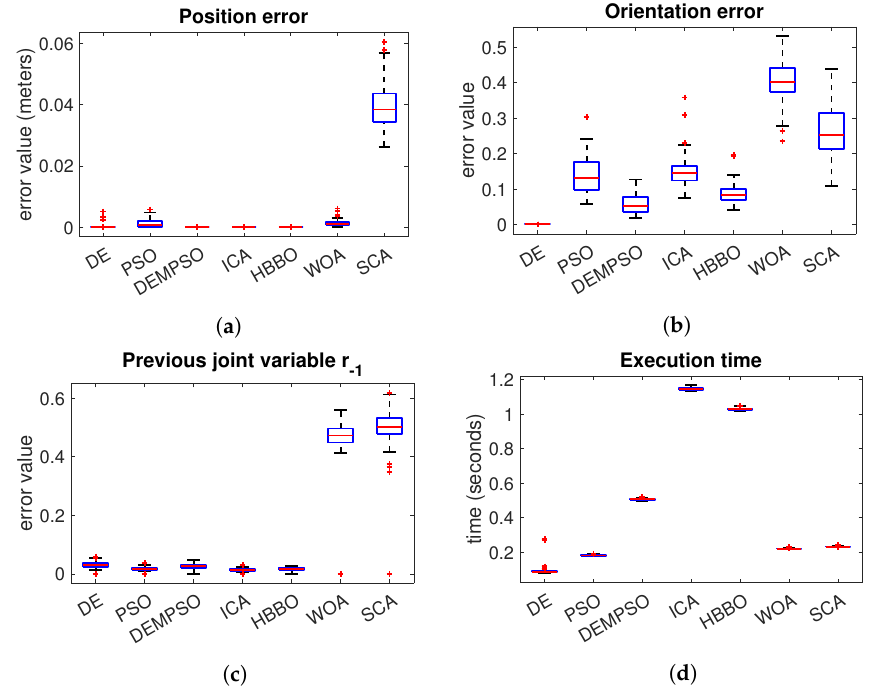
Figure 11. Lemniscate path tracking results with the Baxter robot. ( a ) Baxter end-effector position error (5); ( b ) Baxter end-effector orientation error (15); ( c ) Baxter joint variables error (16); ( d ) Execution time for each point in the